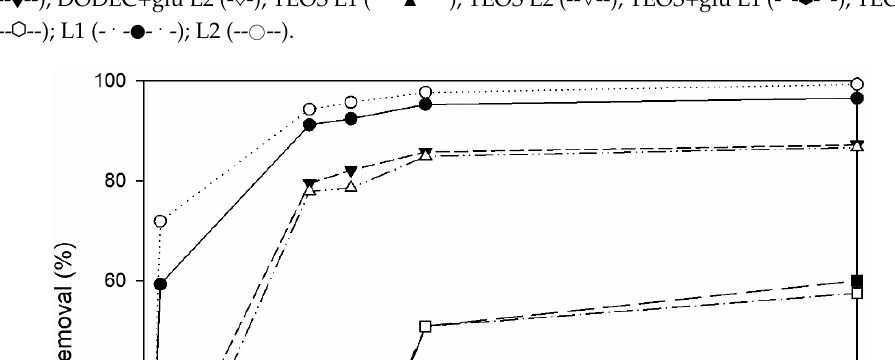
▼ --); pH4 L2 (- .. - △ - .. -); pH5 L1 (-- ■ --); pH5 L2 (- . -□- . -); pH6 L1 (-- ♦ --); pH6 L2 (- ♢ -); pH7 L1 ( … ▲ … );